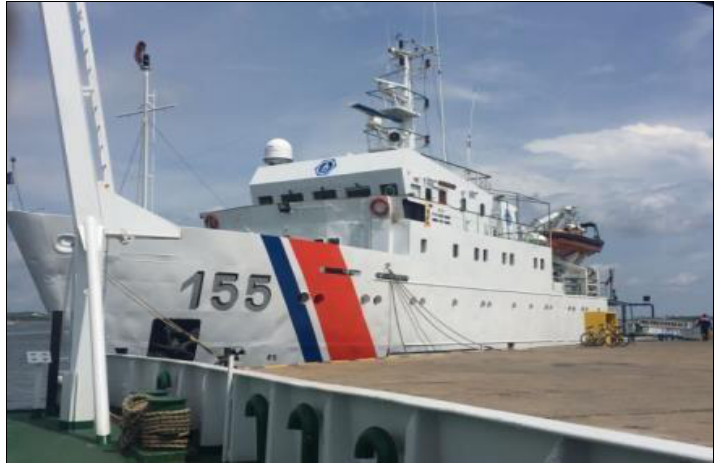
Figure 5. Research vessel ARC Providencia. J. Mar. Sci. Eng. 2020 , 8 , x FOR PEER REVIEW